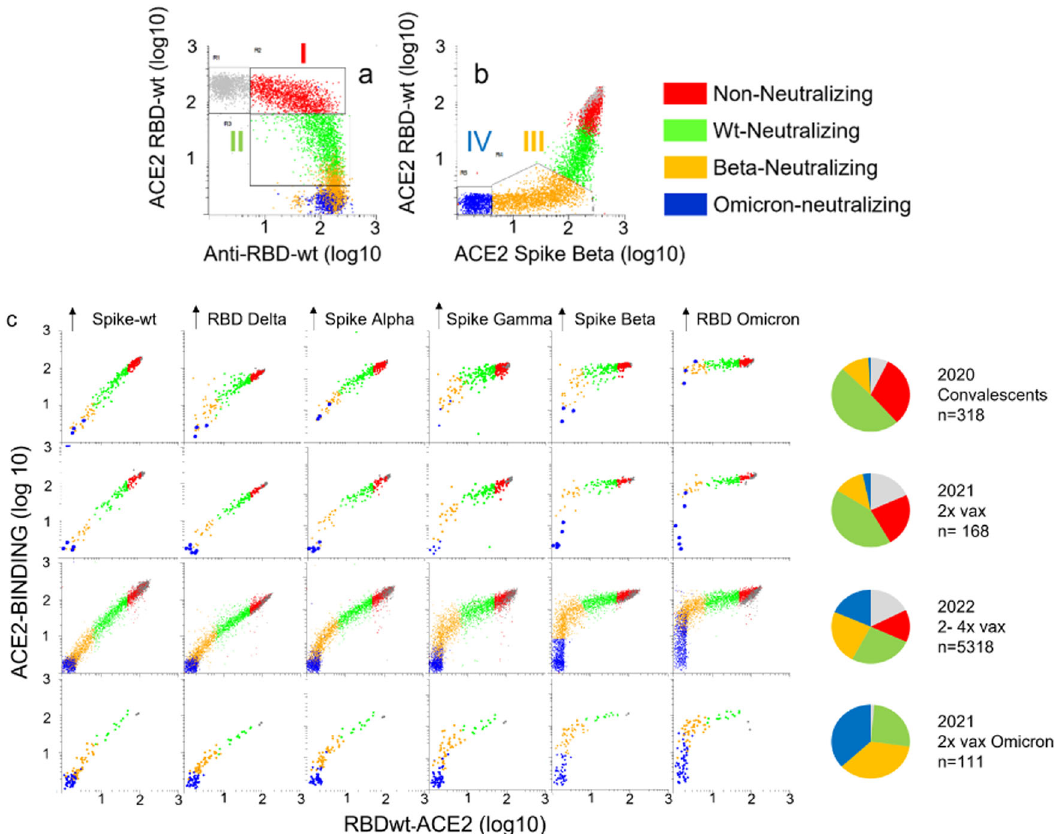
Fig. 5 Effects of serum on ACE2-binding to RBDs and spike proteins from SARS-CoV-2 variants. The dot plots show accumulated data from array-based measurement of 6693 samples. Each dot in the scatter plots correspond to a different sample. a , b Binding of serum IgG or recombinant ACE2 to beads coupled with RBDwt or RBD from the Beta variant as indicated. The beads were incubated with serum diluted 1:1000 or 1:100 prior to labeling with anti-human IgG or recombinant ACE2, respectively. c Binding of ACE2 to beads coupled with RBDs and spike proteins from indicated SARS-CoV-2 variant. The colors correspond to groups within the regions shown in ( a ) and ( b ). Gray dots anti- RBDwt negative sera. Red dots: anti-RBD-positive sera with no or minimal inhibition of ACE2-binding to RBDwt. Green dots: sera with selective and partial inhibition of ACE2-binding to RBDwt. Orange dots: sera with complete inhibition of ACE2-binding to RBDwt and partial inhibition of binding to RBD-Beta. Blue dots. Complete inhibition of ACE2-binding to RBDwt and RBD-beta and strong inhibition of binding to RBD- Omicron BA.1. Source data are provided as a Source Data fi